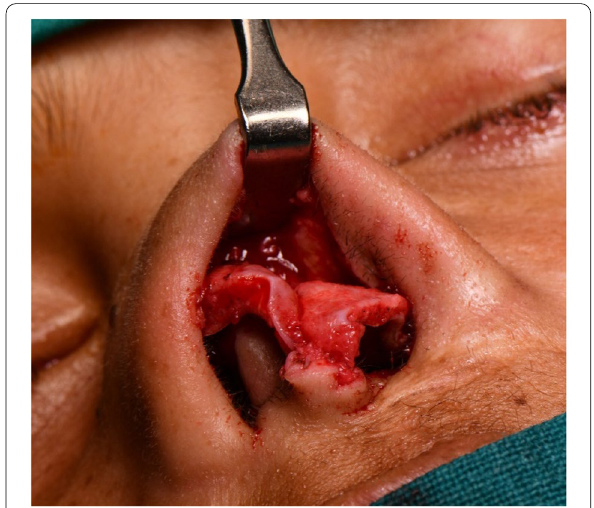
Fig. 1 Exposure of the anatomic deformity after raising the skin and soft tissue